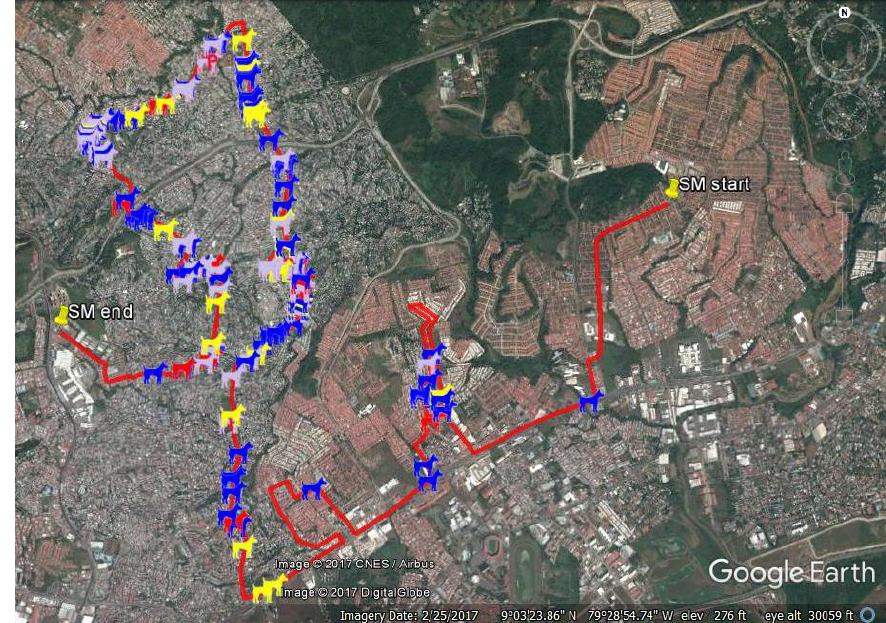
Figure 1. Google Earth image of the “San Miguelito” route in Panama City. The red line shows the route surveyed, the dog icons show the location of the observer when the roaming dog was recorded; blue dogs are male, yellow dogs are female, grey dogs are adults of unknown gender and red dogs are lactating females. Where a sterilisation programme has taken place, using visible marks of sterilisation status such as ear notches or ear tags, black and green icons are used to represent castrated males and spayed females.